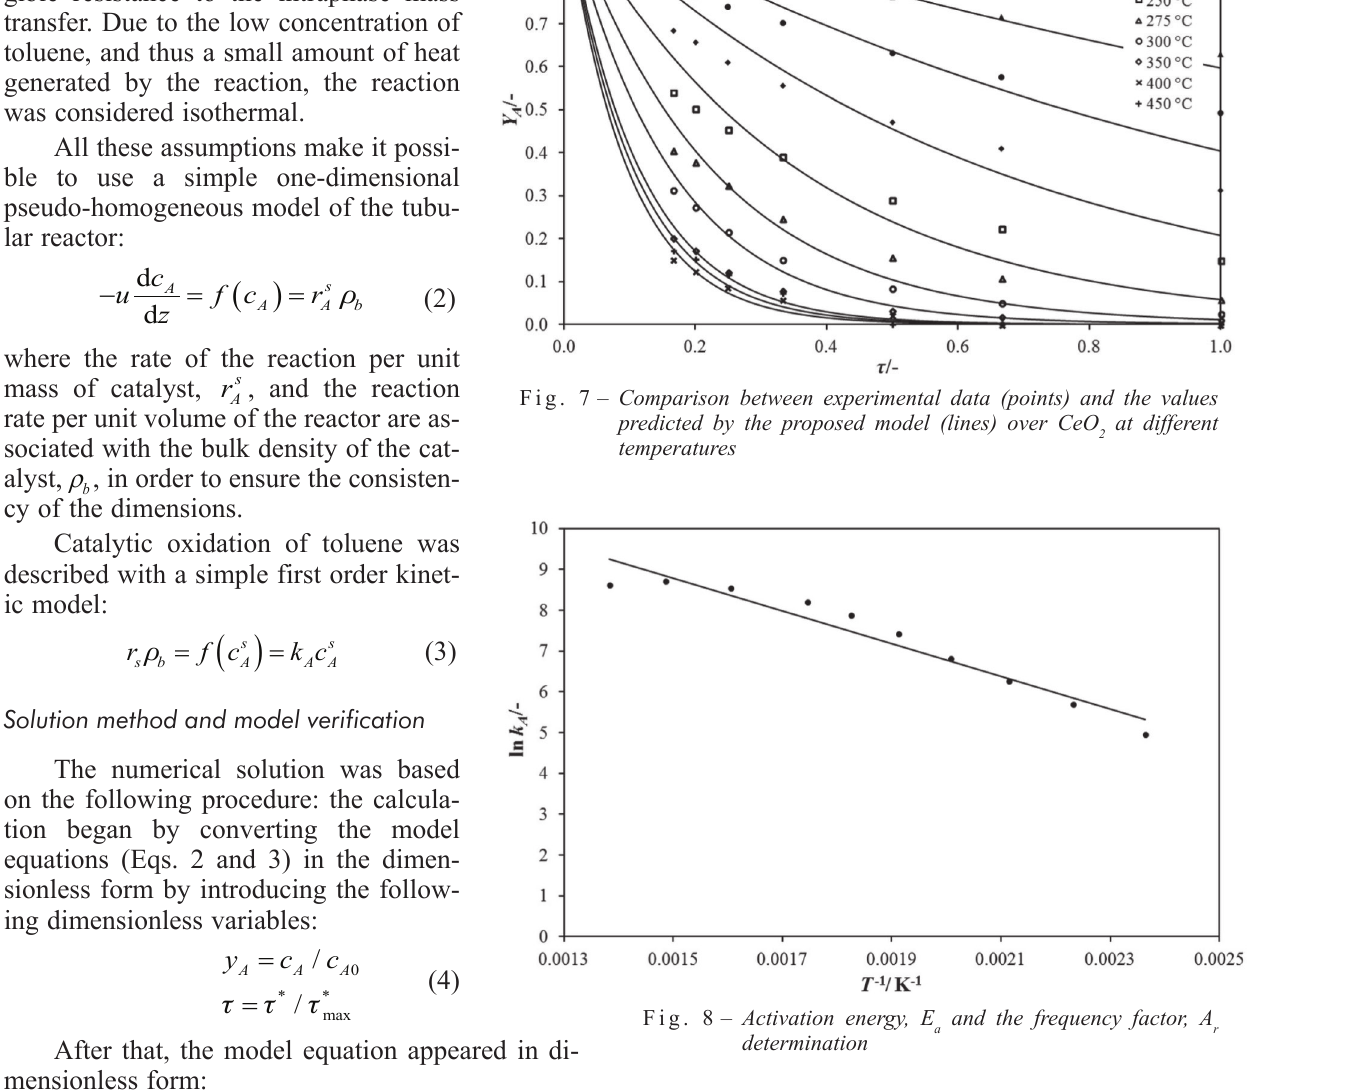
and the frequency factor, A a